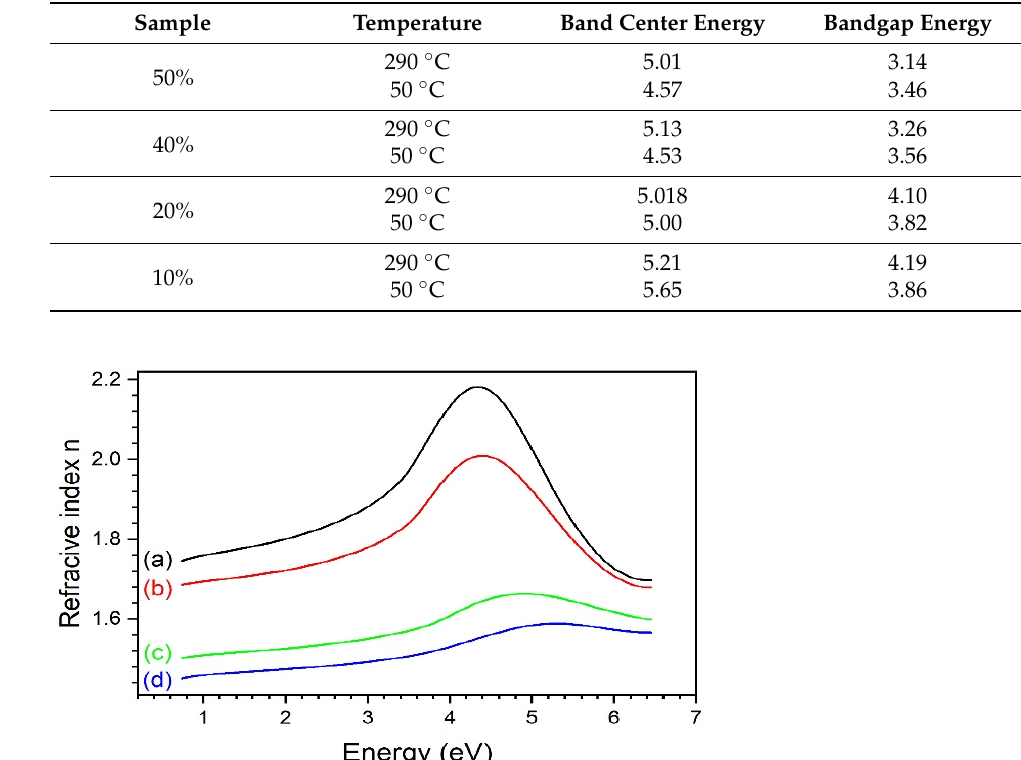
Table 3. Selected parameters fitted by the Tauc–Lorentz model. The fits were performed using data recorded when the sample was at 290 ◦ C or 50 ◦ C for the last time in the experiment.